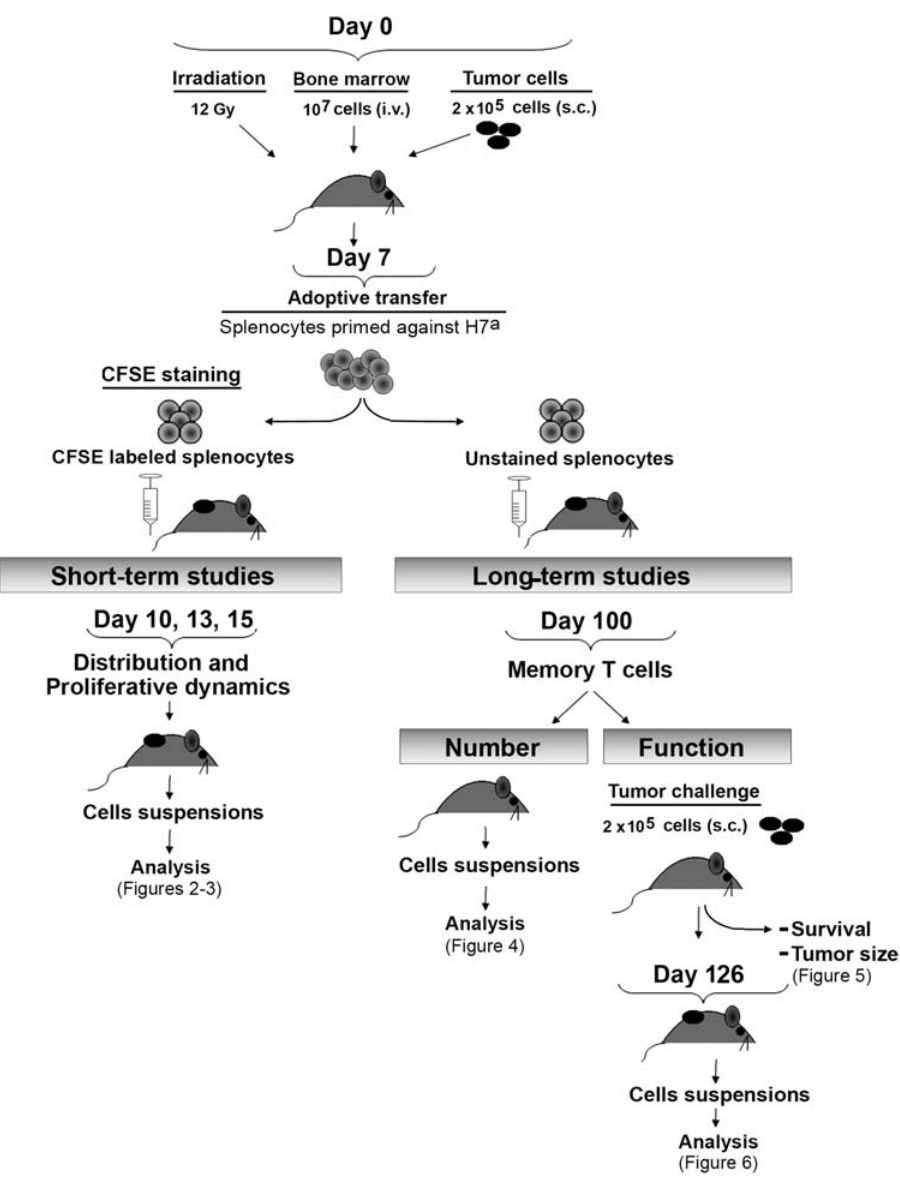
Figure 1. Experimental model and study design. Melanoma-bearing mice received splenocytes primed against H7 a on day 7. Short-term studies on T-cell proliferation kinetics were performed from day 10 to day 15, and long-term studies on memory T cells were initiated on day